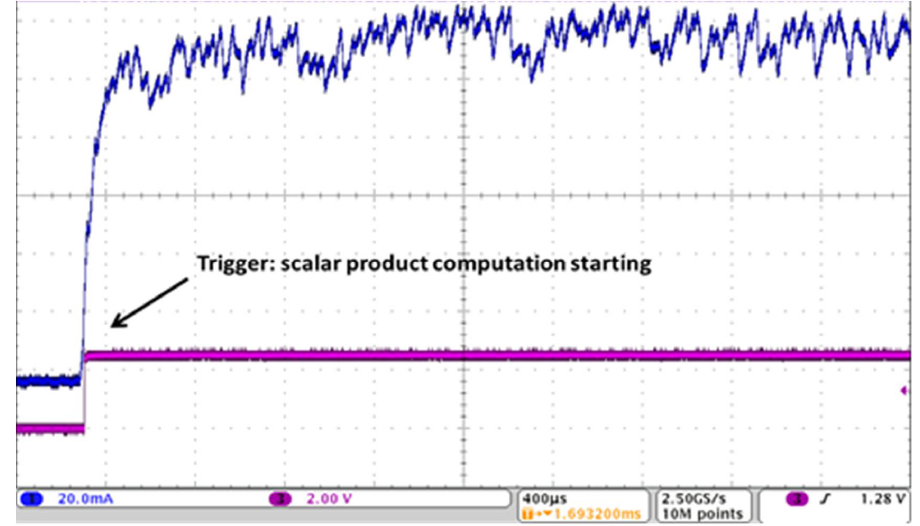
Figure 5. Effect of the countermeasure: power trace as recorded on the pins of the Kintex-7 FPGA after countermeasure activation, to be compared to the trace in Figure 1.